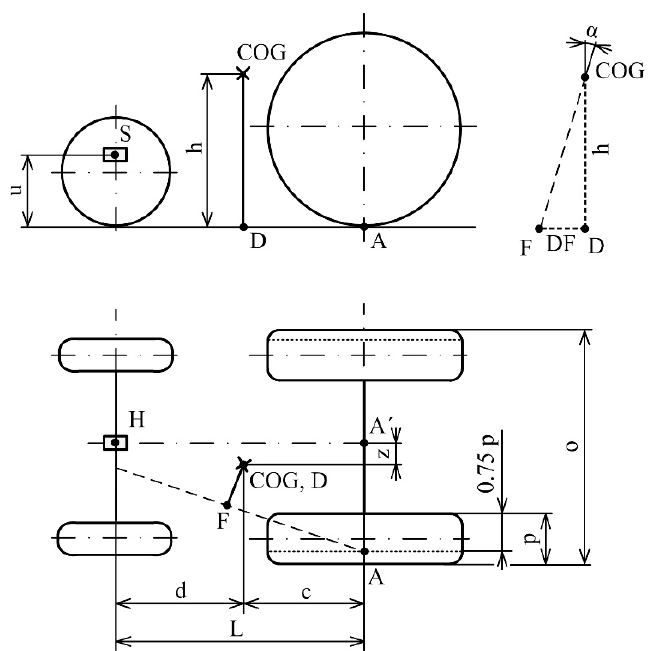
Figure 6. Determination of tractor lateral stability according to [14]: o— overall tire width of the fixed axle; p— tire width on the fixed axle; u— height of the swelling axle pivot point; L— wheelbase; c, d— longitudinal coordinates of COG; h —vertical coordinate of COG; z— lateral position of COG; α — static overturning angle; AA’— base line of the stability triangle; DF— slope line; A, A’, B, C, D, F, H, M, S — specific points needed for determination of abscissae .